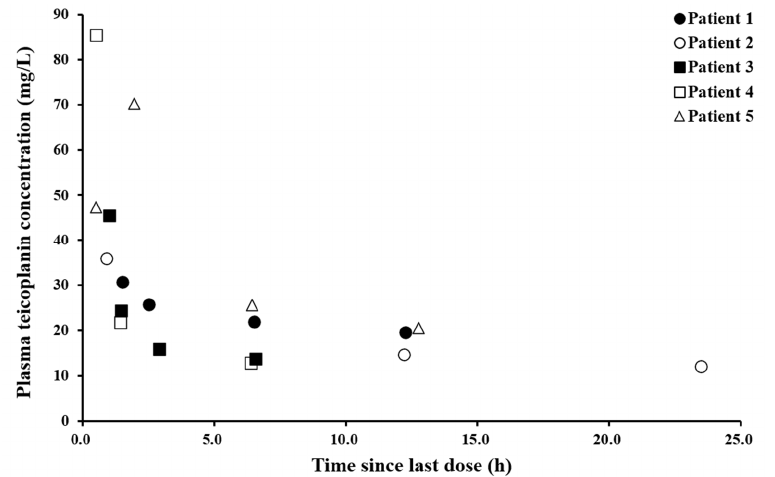
Figure 4. The plasma teicoplanin concentration–time since last dose curve from patients who were treated for methicillin-resistant Gram-positive organisms.